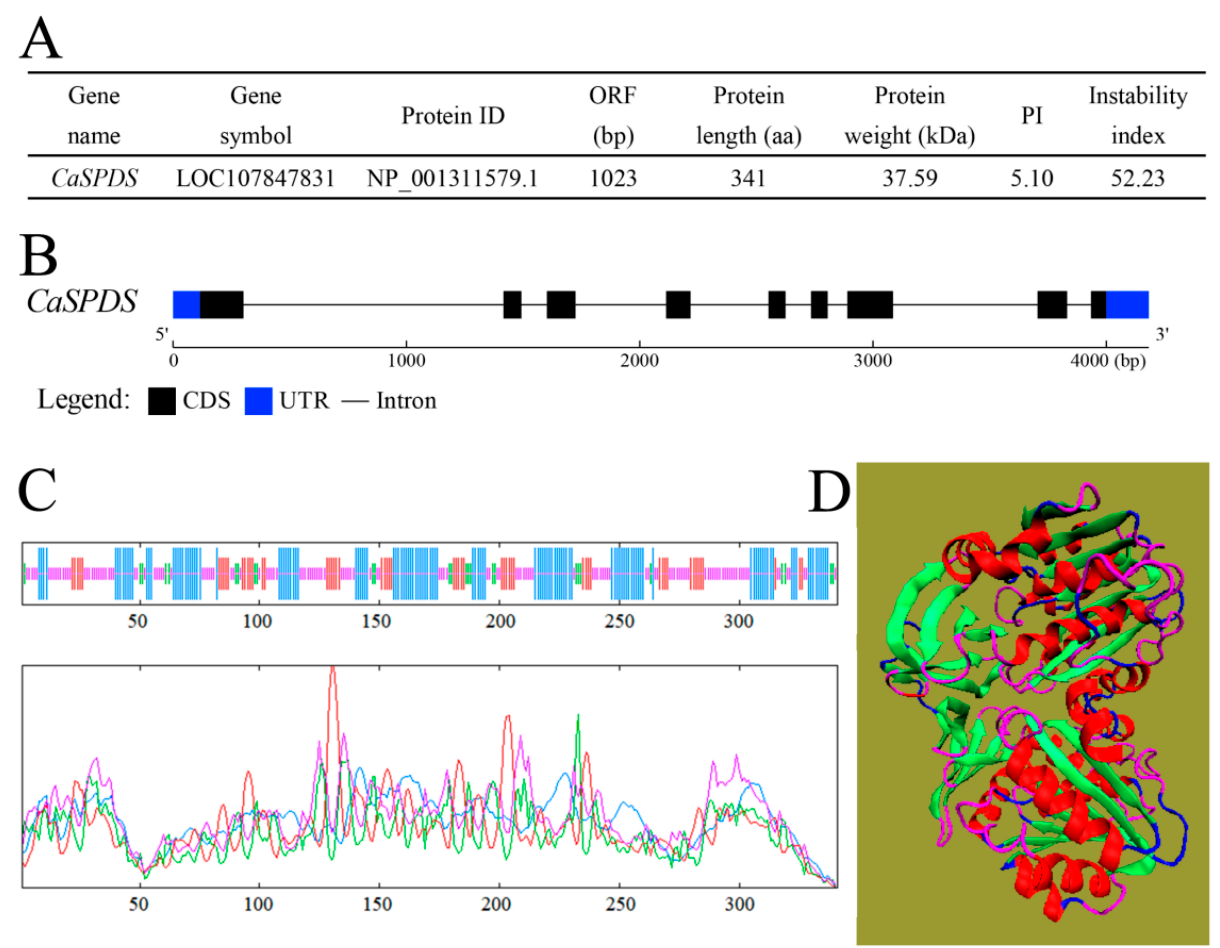
Figure 1. Basic information about CaSPDS sequence. ( A ) Detailed physicochemical properties of CaSPDS . ( B ) Genomic structure of CaSPDS . Blue rectangles denote upstream/downstream sequences; black rectangles and lines denote exons and introns, respectively. ( C ) Predicted secondary structure of CaSPDS. Numbers represent the number of amino acids. ( D ) Predicted tertiary structure of CaSPDS. Red denotes the alpha helices, green extended strands, purple beta turns, and blue random coils.